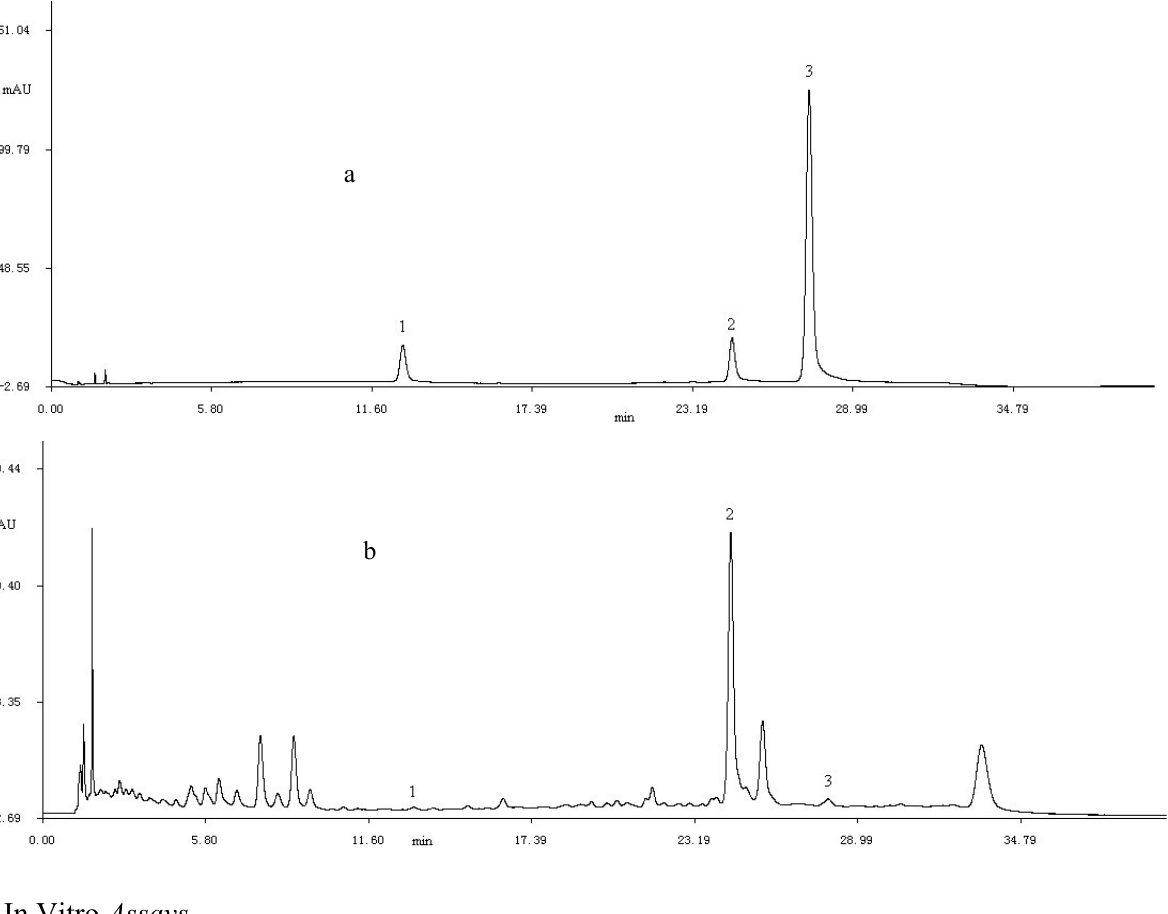
Figure 2. The HPLC chromatograms of standard samples ( a ) and purified flavonid ( b ) at 280 nm; 1. rutin; 2. kaemperol; 3.